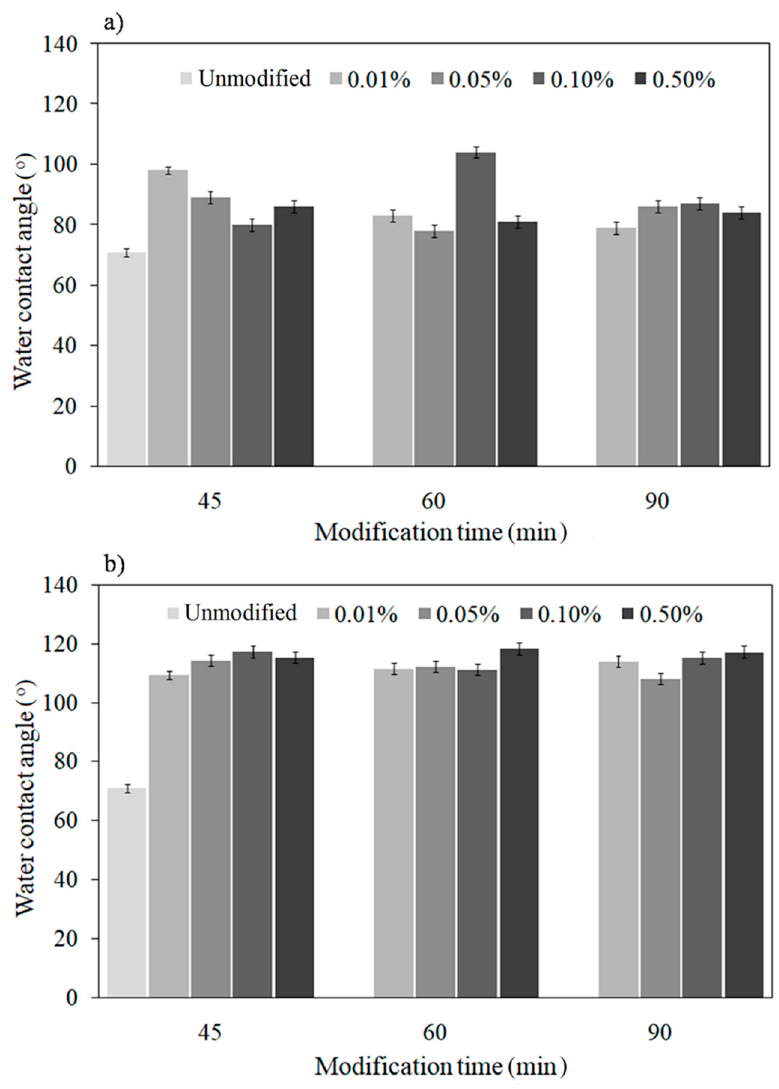
Figure 2. Water contact angle values for different deposition parameters of ( a ) PFDA and ( b ) PFDPA.